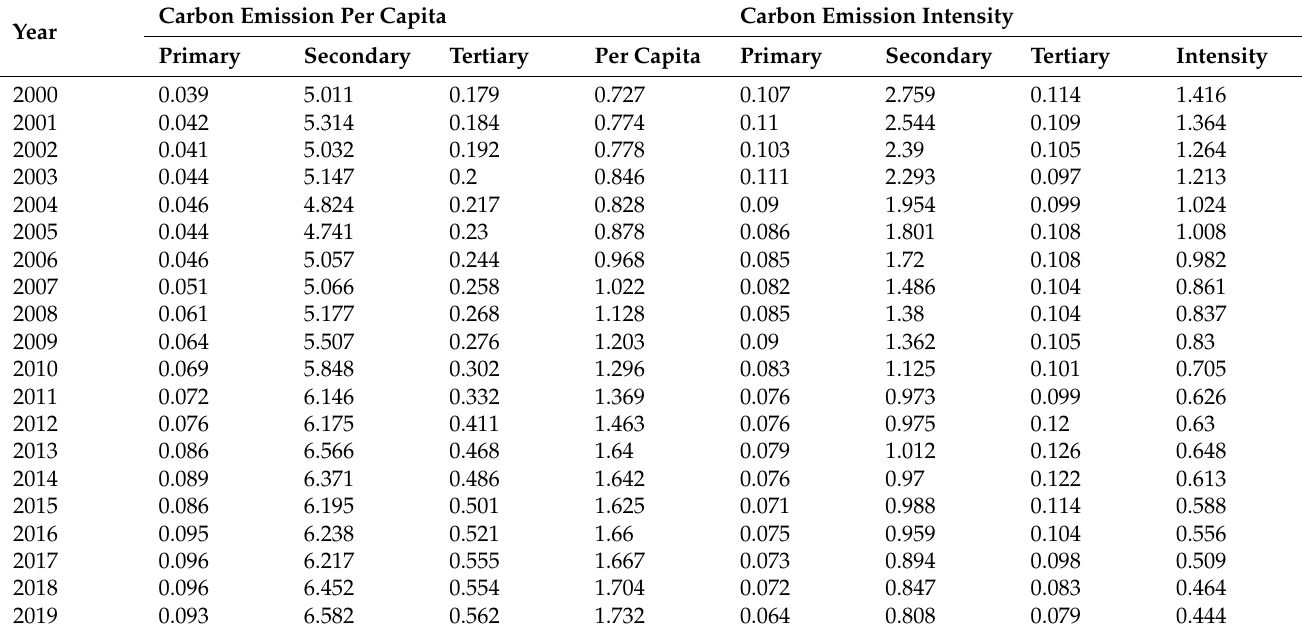
Table 6. Statistics of the carbon emissions (tons of carbon/people, tons of carbon/million